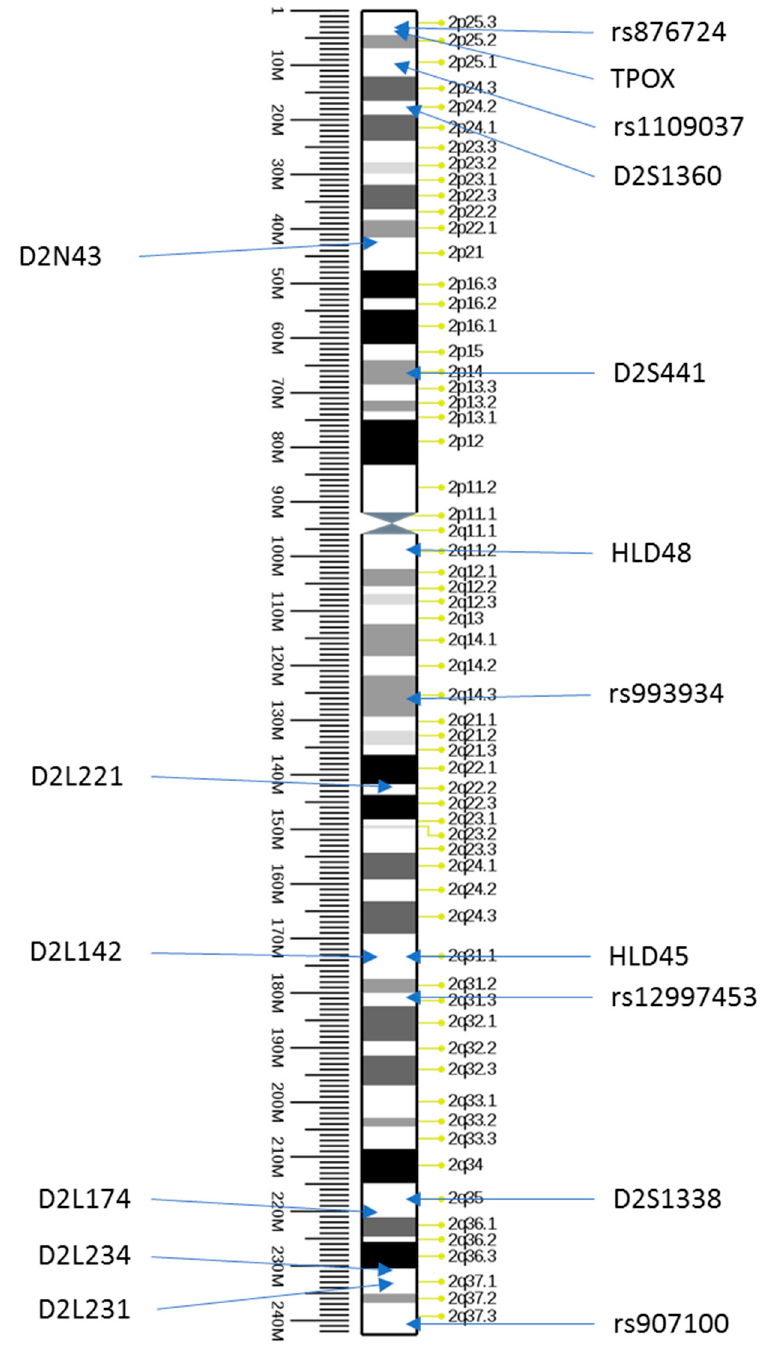
Figure 1. Structure of human chromosome 2 with indicated loci of tested markers at chromosome (source: Ensemble, modified).